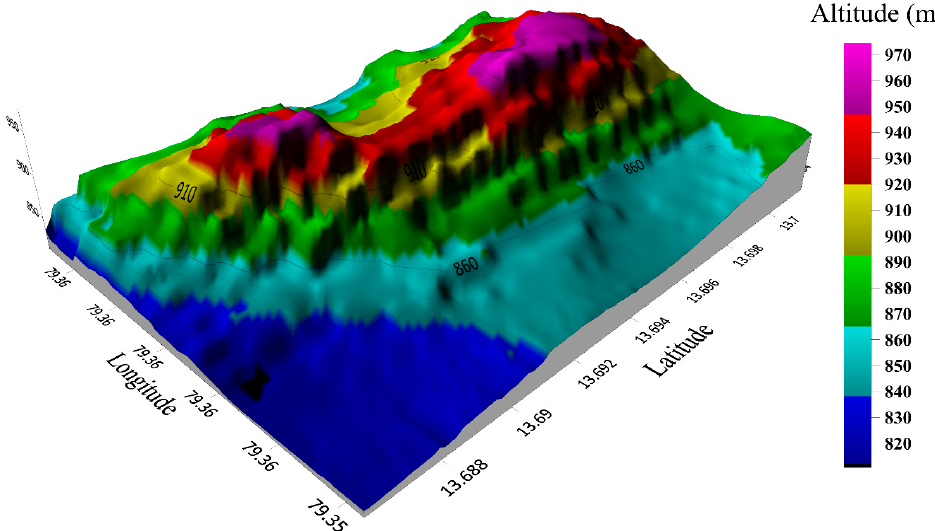
Figure 2. Surface plot of the selected site.